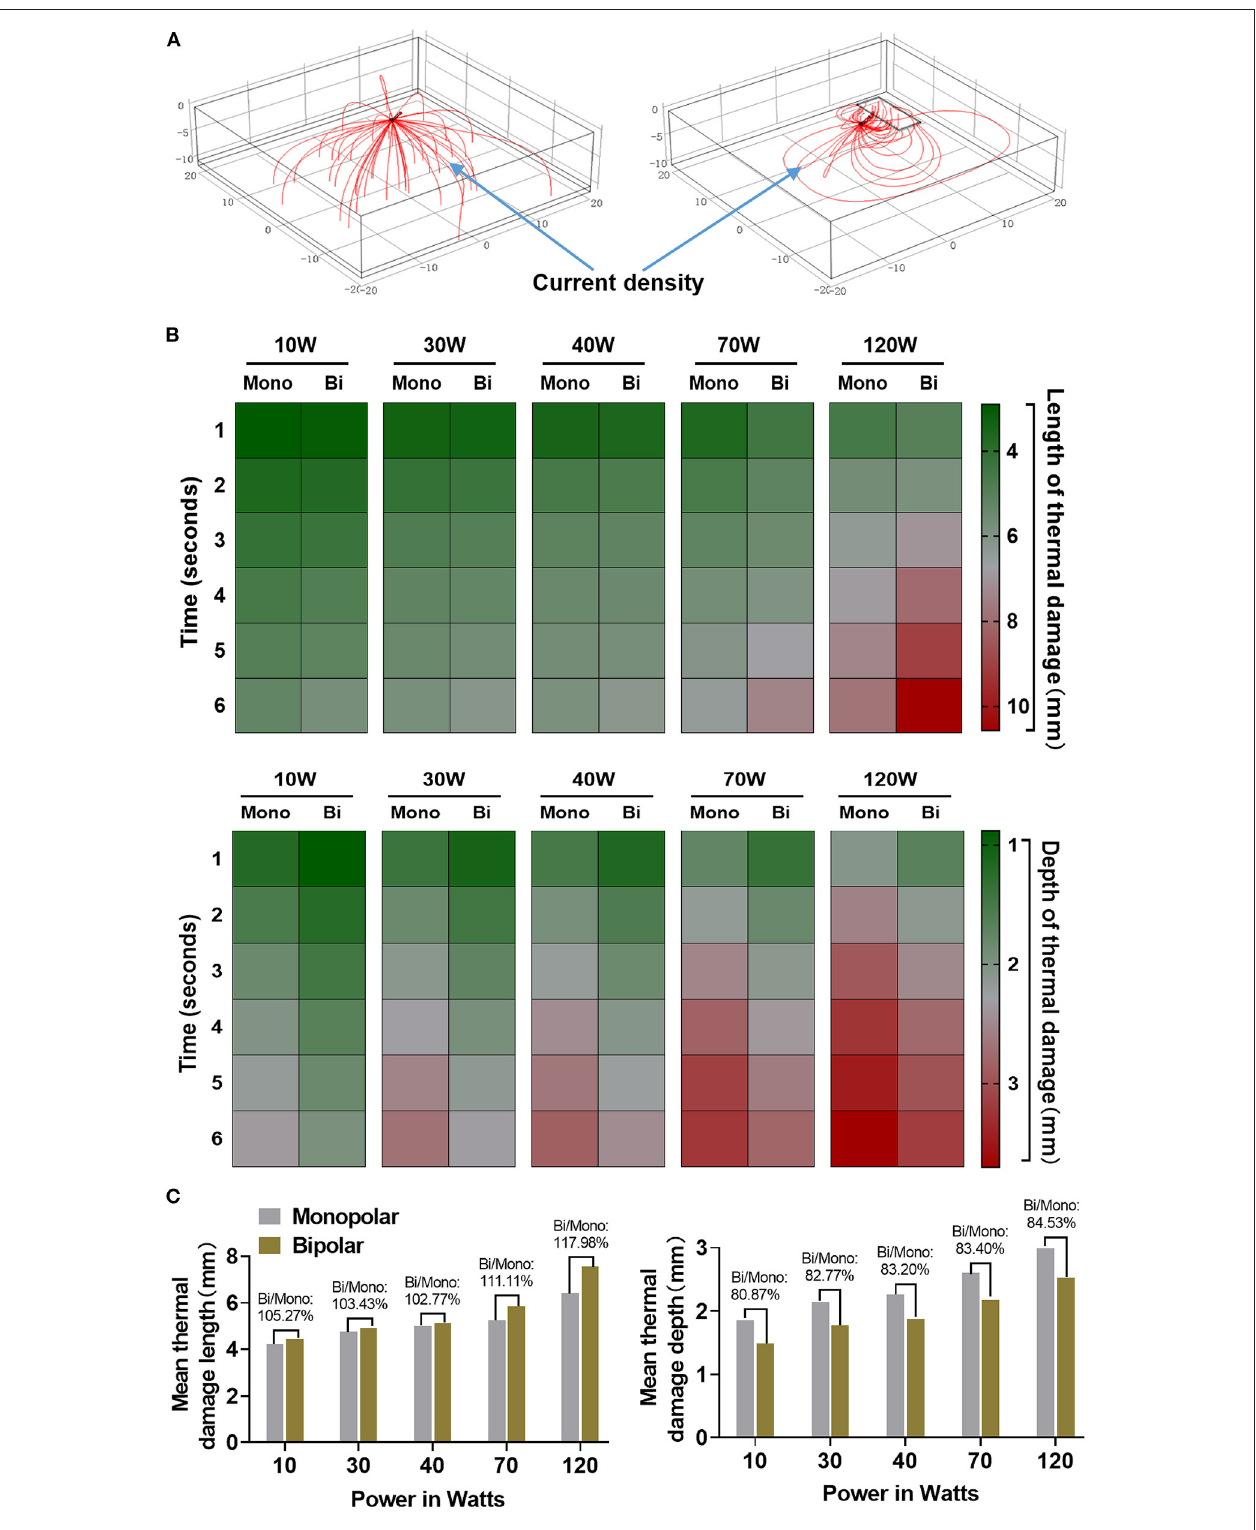
FIGURE 6 | The finite element analysis of thermal damage caused by the monopolar and bipolar knives. (A) Current density streamline diagrams of monopolar and bipolar electrosurgical models. (B) The horizontal and vertical thermal damage analyzed by the finite element method under power of 10, 30, 40, 70, and 120W with different times between monopolar and bipolar knives. (C) The bipolar-to-monopolar ratio of the average thermal damage length and depth under different powers between two knives.